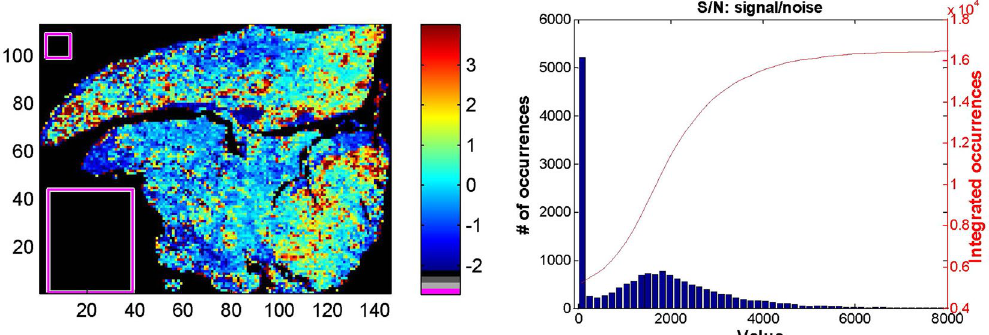
Figure 8. Left: represents the 64 Zn/A 1654 FTIR ratio. The two rectangles include a total of 1705 spectra whose average was subtracted from all spectra of the image. For all values at each wavenumber/element, the mean was subtracted and it was divided by the standard deviation. Right: distribution of the SNR through the FTIR image. The red curve reports the integrated